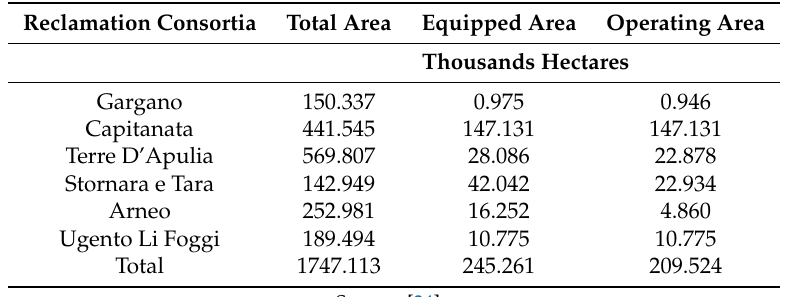
Table 2. Main features of collective delivery networks for irrigation water in Puglia.